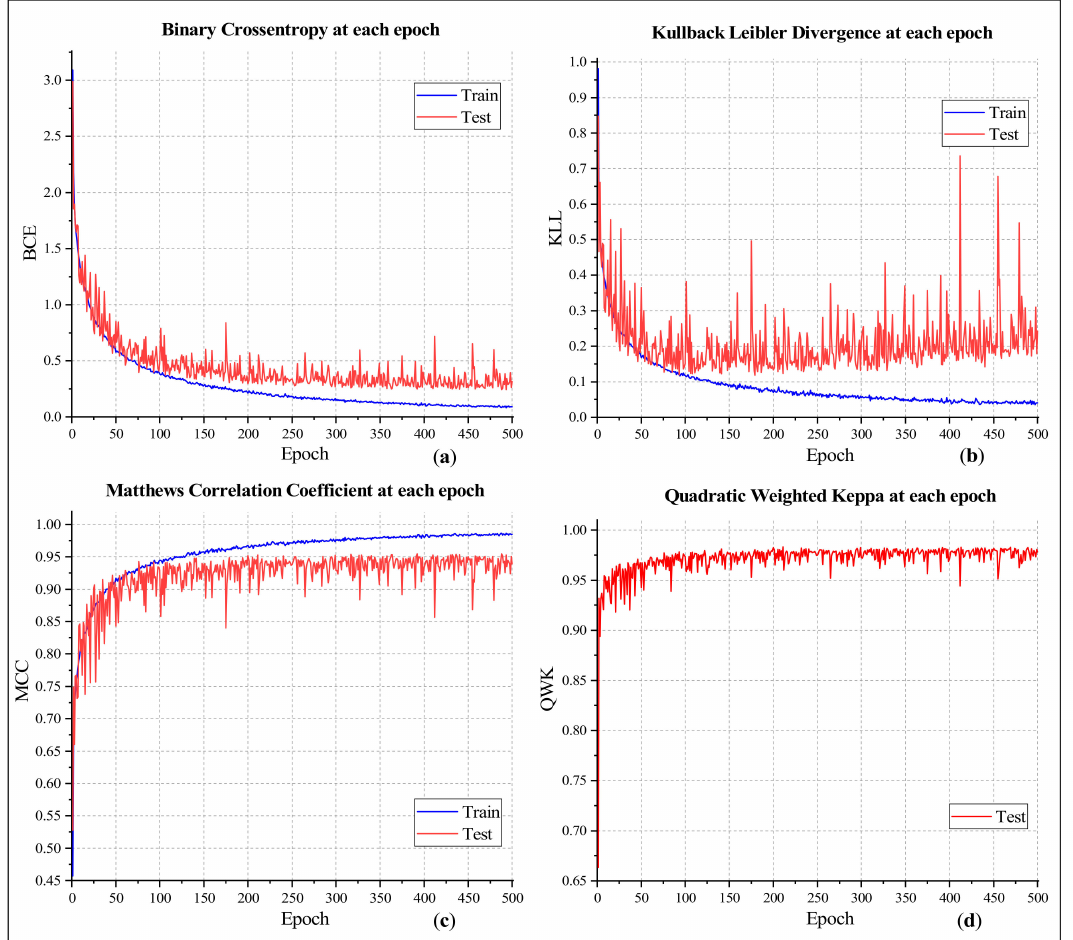
Figure 9. Classification outcome showing ( a ) BCC, ( b ) KLL, ( c ) MCC, and ( d ) QWK values at each epoch.